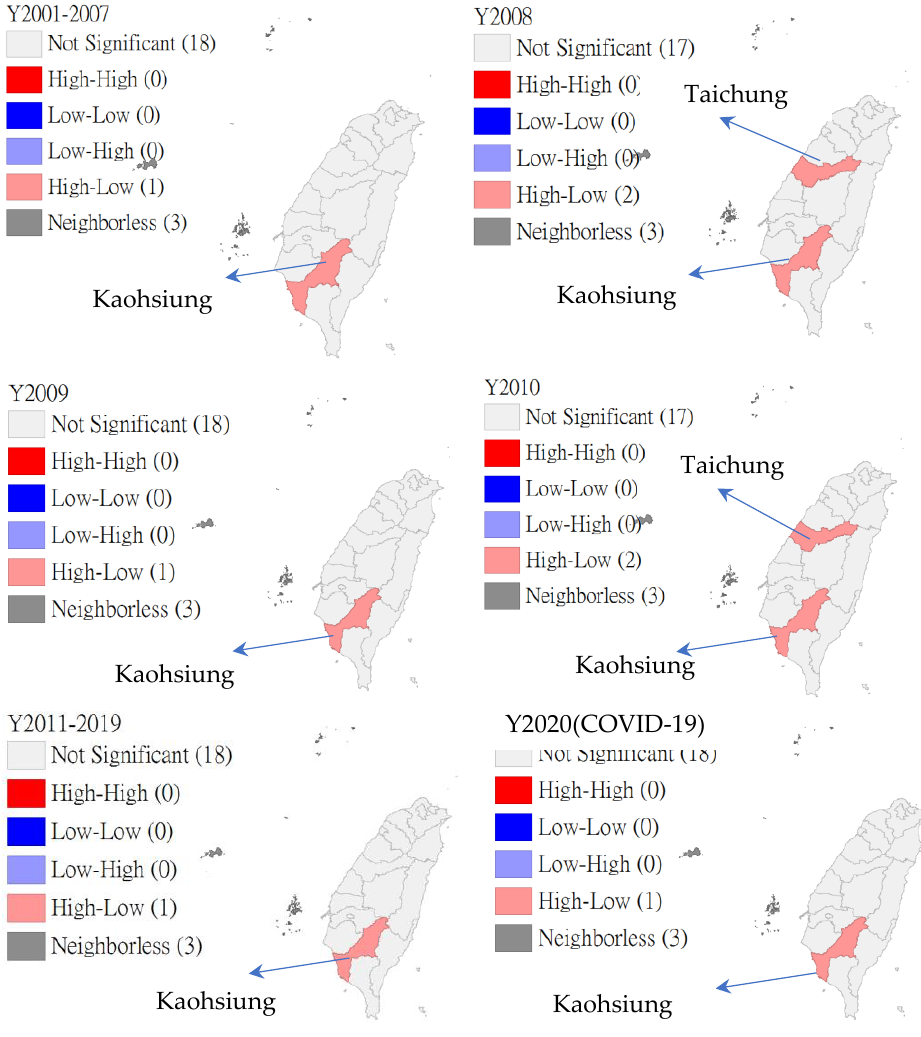
Figure 3. LISA graph of NABIT from PSE enterprises among Taiwan cities from 2001 to 2020.